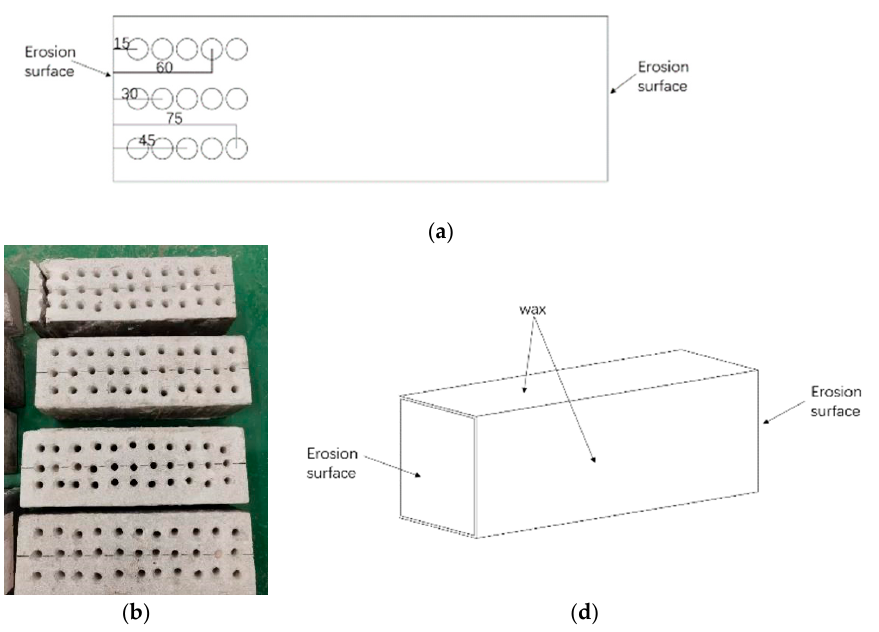
Figure 5. Drill hole for powder specimen ( a - c ).